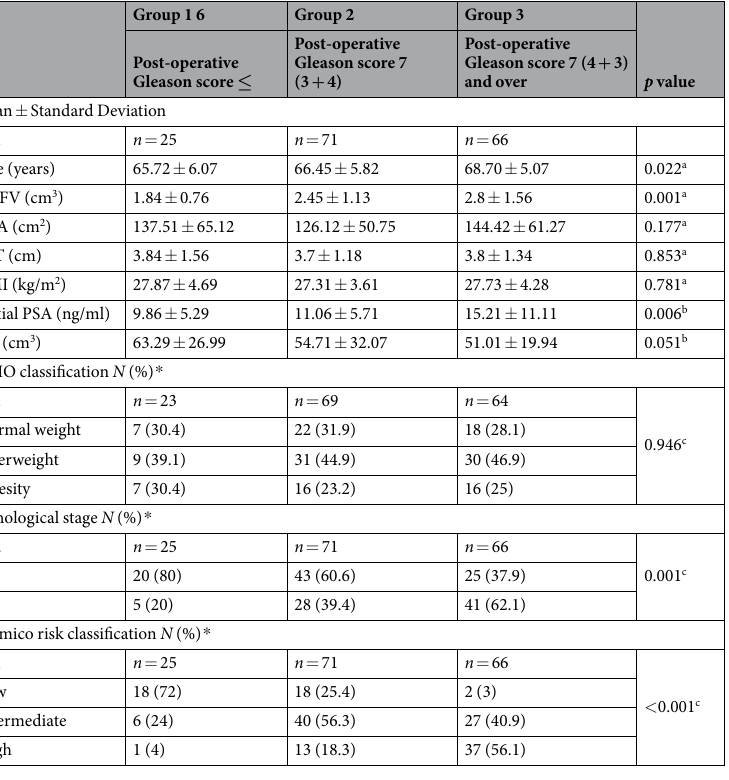
Table 3. Patient characteristics. NPFV = Normalised periprostatic fat volume; AFA = Abdominal fat area; SFT = Subcutaneous fat thickness; BMI = Body mass index; PSA = Prostate specific antigen; PV = Prostate volume. Patients were stratified according to post-operative Gleason score. a ANOVA, b Kruskal-Wallis test, c χ 2 test. * (%) within each group. P value is significant <